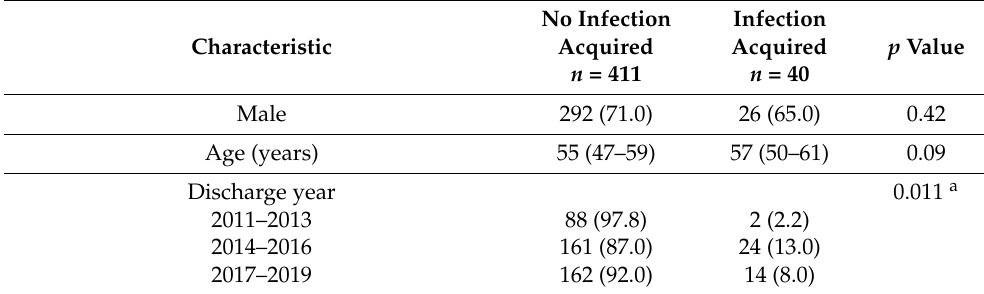
Table 3. Characteristics of patients who did vs. those who did not acquire MRO colonization during